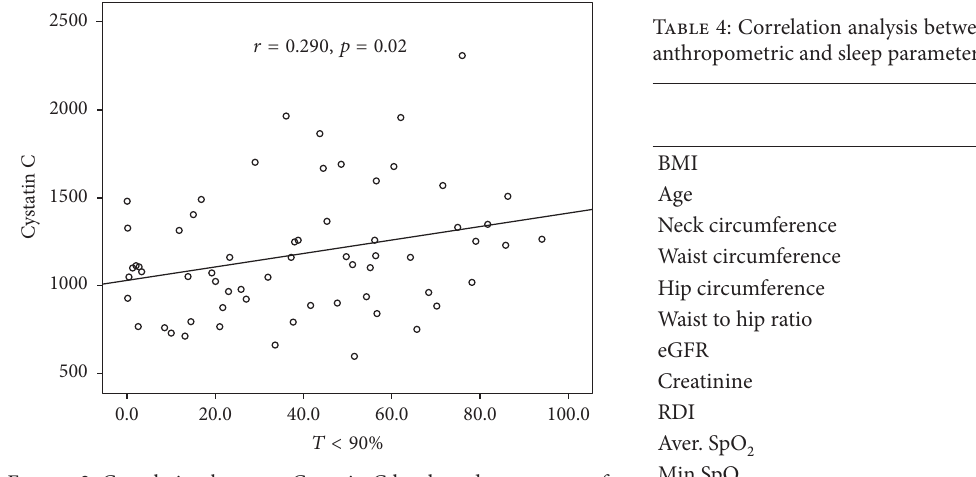
Figure 2: Correlation between Cystatin C levels and percentage of time with oxyhaemoglobin saturation < 90% ( T < 90%) during sleep in OSAS patients.